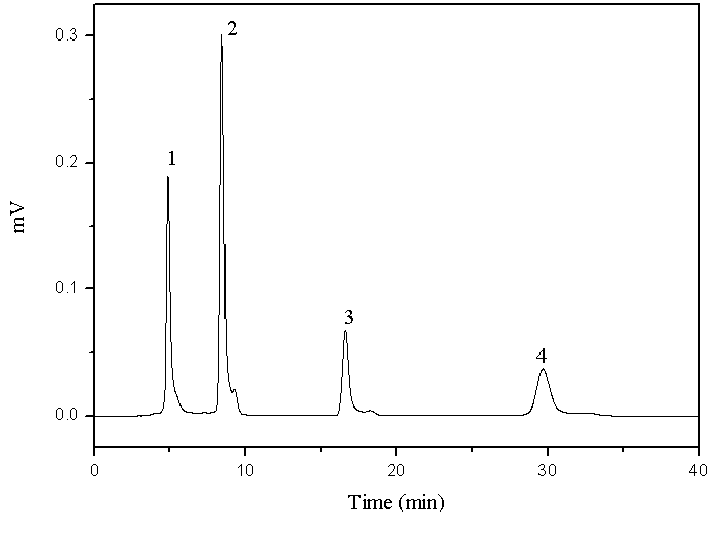
Figure 4. Chromatogram of the four target compounds with 0.01 mol/L of acetic acid as the mobile phase additive. 1: chlorogenic acid, 2: caffeic acid, 3: scoparone, 4: